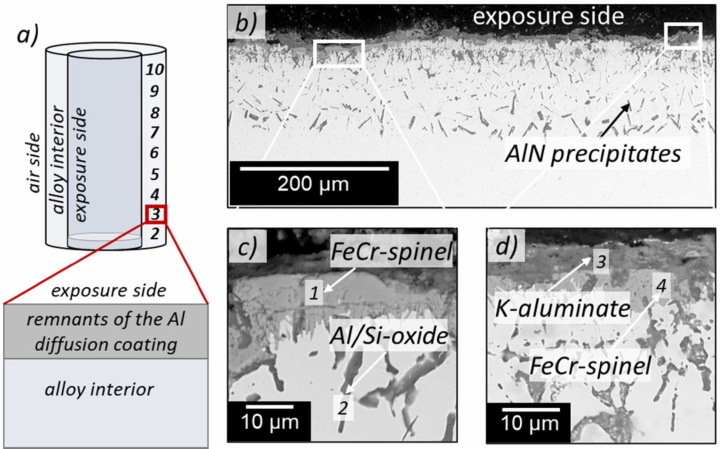
Figure 4. ( a ) Schematic illustration of the vessel highlights the main corrosion regimes in the hottest section after 4000 h exposure to evaporated alkali carbonate species. ( b ) Cross-section SEM image